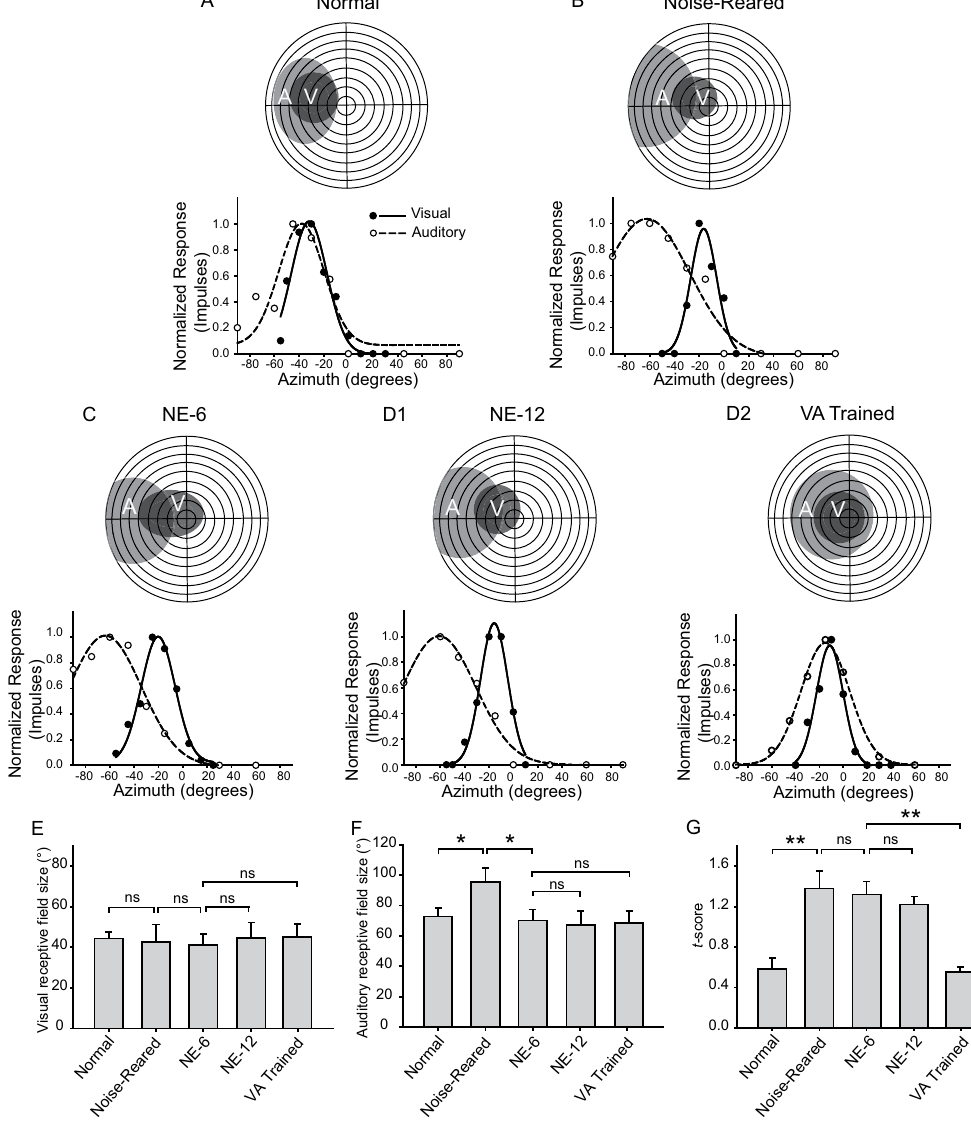
Figure 4. Visual-auditory receptive field register increases with cross-modal exposure. ( A ) The classically- defined visual and auditory RFs of a representative neuron from a normally reared animal are shown at the top, with the visual (solid line) and auditory (dashed line) spatial response profiles shown below (y-axis = mean # impulses/response, normalized by maximum). Note the good register between the RFs using either metric. ( B ) However, this cross-modal RF register was very poor in most neurons of noise-reared animals during baseline tests, and is illustrated by the exemplar. ( C ) Poor cross-modal RF register remained evident even after 6 months of subsequent housing in the normal environment (NE-6). ( D1 ) The poor RF registers remained even after an additional 6 months in the normal housing condition (NE-12). ( D2 ) However, animals given weekly cross- modal exposure sessions (VA trained) over the same period showed a significant improvement in RF register. ( E , F and G ) Bar graphs summarize the average size (diameter) of the visual and auditory RFs in the population, and the t -scores (higher = greater RF misalignment, see text) in the five conditions. Error bars indicate SEM, ns = non-significant. Other conventions are the same as in previous